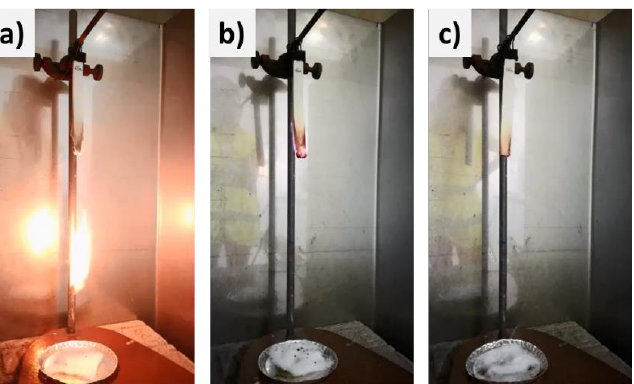
Figure 8. EDPM probes during vertical burning test. ( a ) EPDM Reference, polymer drips and burns the cotton 51 s after third flame application; ( b ) EPDM OSep, polymer burns for more than 60 s without dripping; ( c ) EPDM OSepZHS, polymer fades out at 4 s after third flame application without dripping.